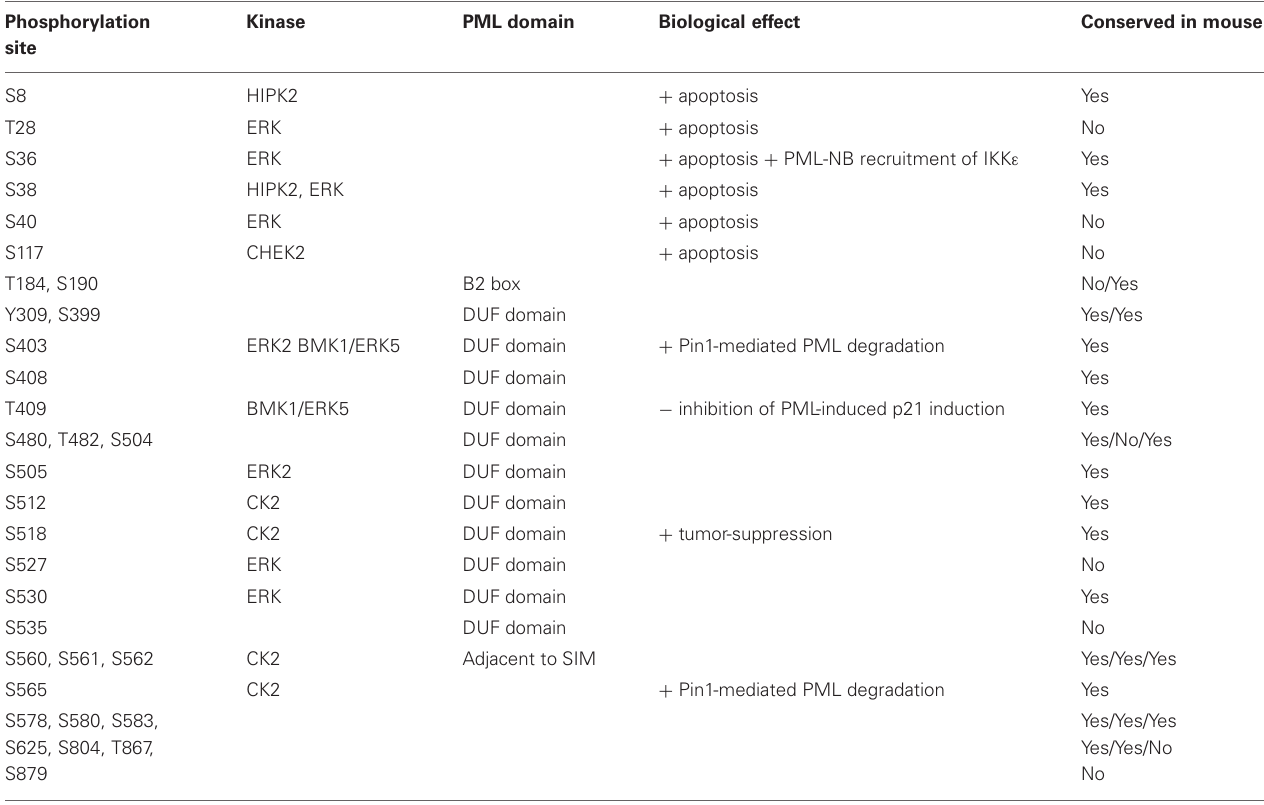
Table 2 | List of PML phosphorylation sites retrieved from published literature and the public PhosphoSitePlus © database. Phosphorylation PML domain Biological effect Conserved in